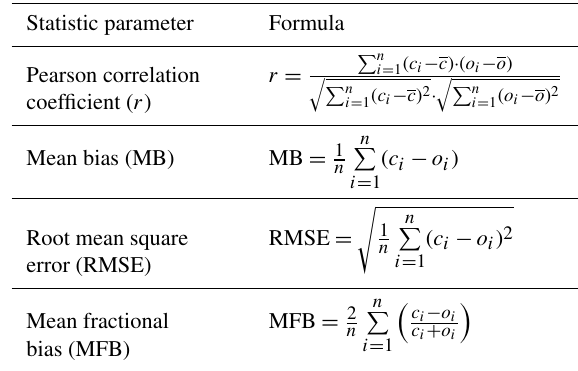
Table B1. Definitions of the verification statistics used in the study. o i and c i are the observed and the modelled concentrations at time and location i , respectively; o and c are their averages; n is the num- ber of